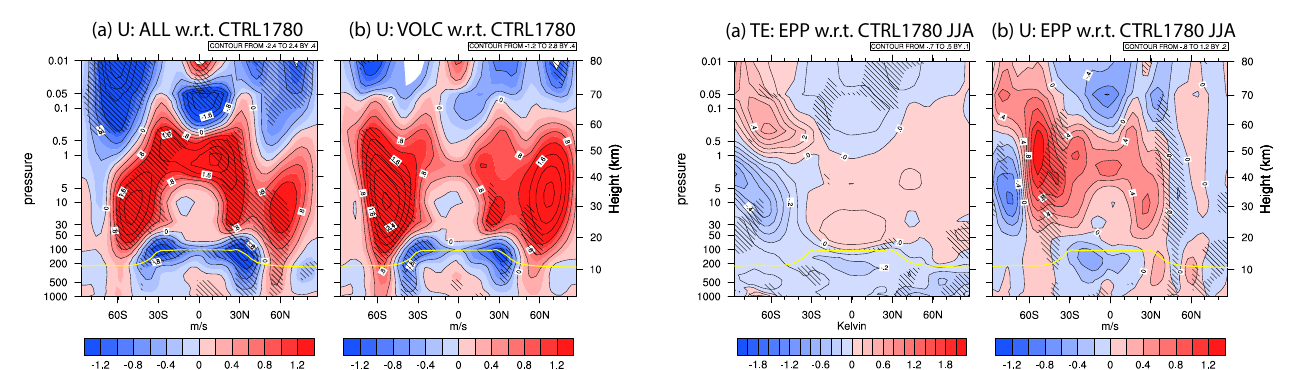
Fig. 8. Absolute differences in mean zonal wind of the DM- ALL and the DM-VOLC experiments with relation to the DM- CTRL1780 forcing run. Hatched areas are significantly different on a Student’s t test with α = 5%. The yellow line illustrates the WMO tropopause height.